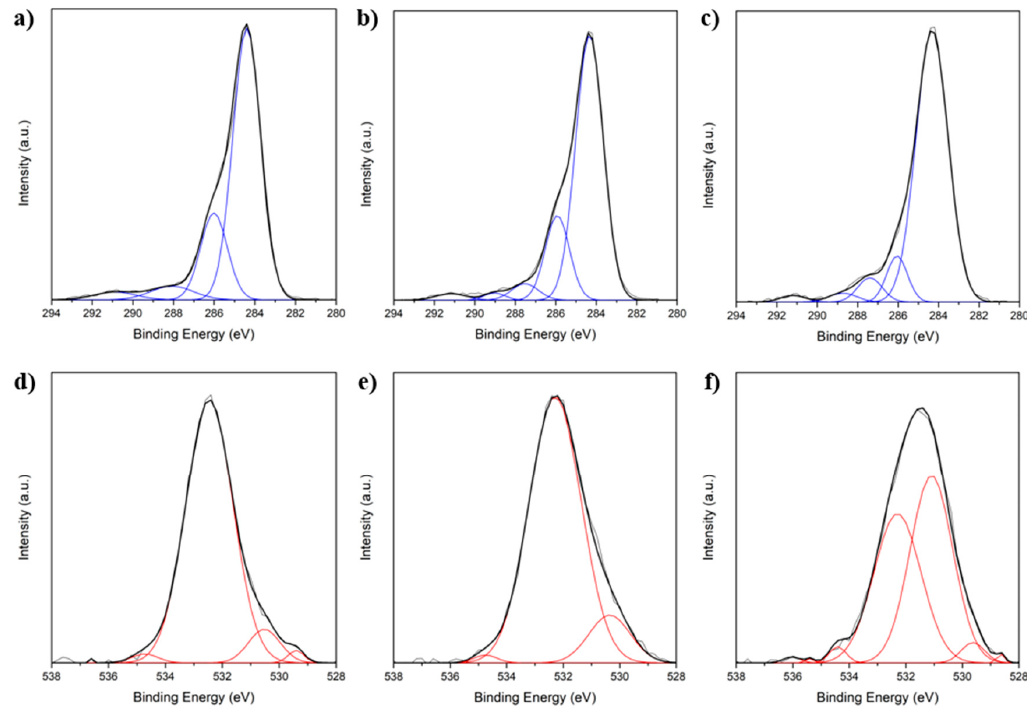
Figure 1. C1s ( a – c ) and O1s ( d – f ) measured by X-ray photoelectron spectroscopy for ( a , d ) untreated; ( b , e ) H 2 O 2 -treated; and ( c , f ) aqua regia /CaCl 2 -treated C-fibers.